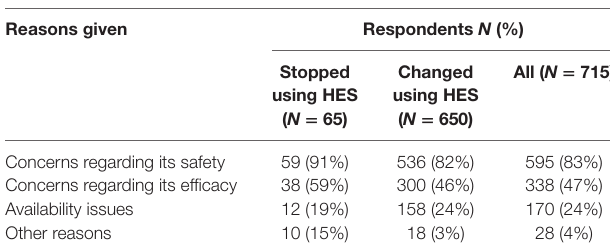
TaBle 5 | Reasons reported by survey respondents for stopping or changing their use of hydroxyethyl starch (HES).